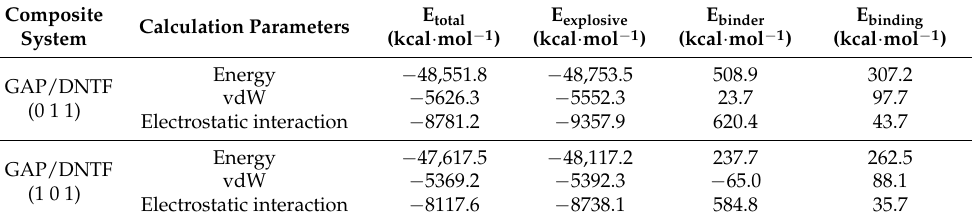
Table 3. Binding energy between GAP and DNTF (0 1 1) and DNTF (1 0 1)